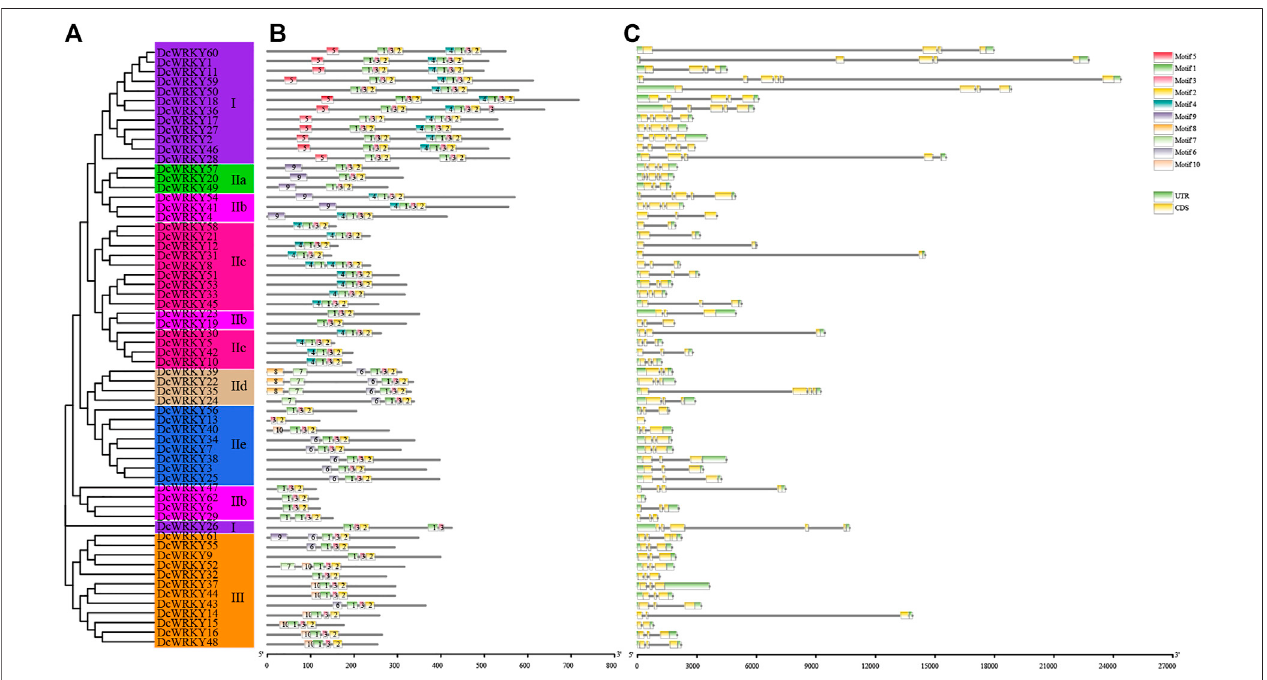
FIGURE 2 | Phylogenetic relationships, motifs, and structures of DcWRKY family members. (A) A phylogenetic tree of 62 DcWRKY proteins was constructed with the Maximum Likelihood method. The different subgroups are indicated with different background colors and letters. (B) Conserved motifs of DcWRKY proteins. Different motifs are represented by various colored boxes and different numbers. (C) Exon/intron structures of DcWRKY genes. Exon(s), intron(s), and UTR(s) are represented by yellow boxes, black lines, and green boxes, respectively. The phylogenetic tree, conserved motifs, and gene structures were predicted with